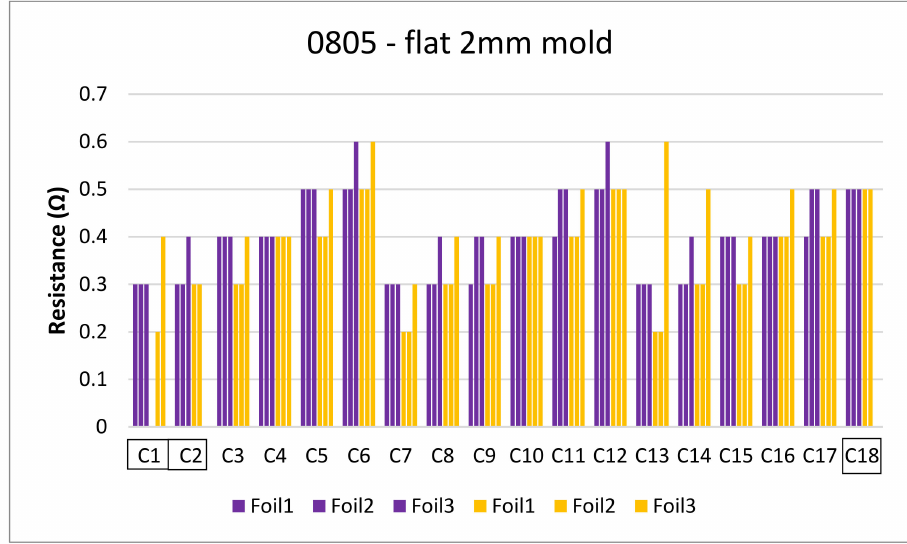
Figure 31. Resistance measurements for 0805 resistors molded in the 2 mm flat